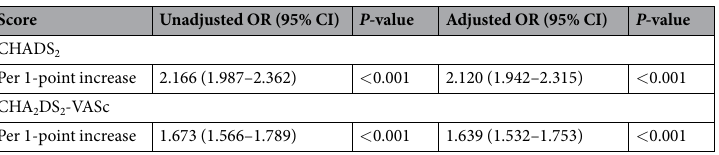
Table 3. Associations of CHADS 2 and CHA 2 DS 2 -VASc scores with prevalence of acute myocardial infarction in patients with atrial fibrillation. OR, odds ratio; CI, confidence interval. Adjusted analyses were controlled for hyperlipidaemia, hyperuricemia, hyperthyroidism, hypothyroidism and obstructive sleep apnea.